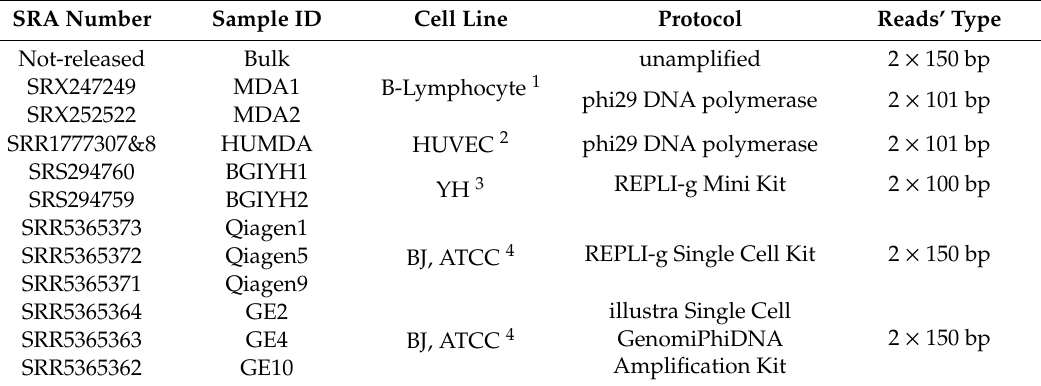
Table 4. The summary of data downloaded from